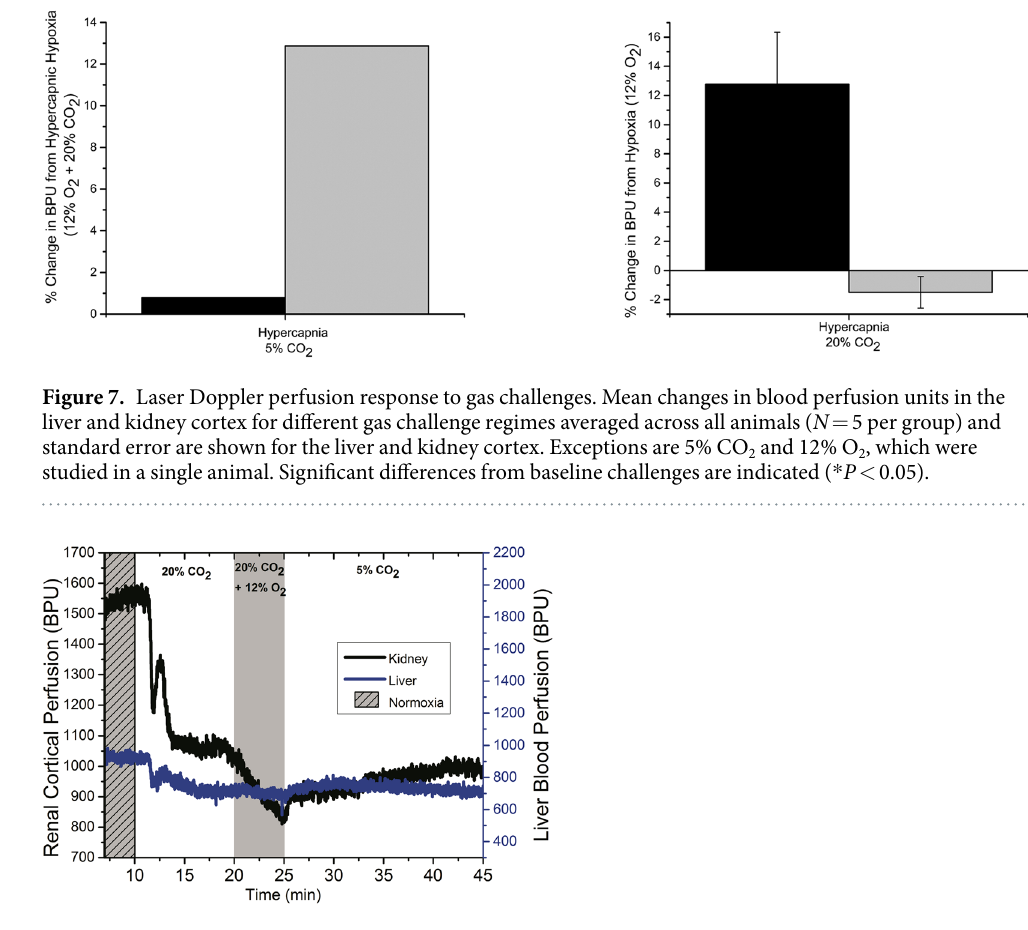
Figure 8. Real-time tissue perfusion response in the liver and kidney cortex. Dynamic laser Doppler perfusion recordings are shown for the following gas sequence: normoxia → hypercapnia (20% CO 2 ) → hypercapnic hypoxia (20% CO 2 + 12% O 2 ) → hypercapnia (5% CO 2 ). Units are in relative blood perfusion units